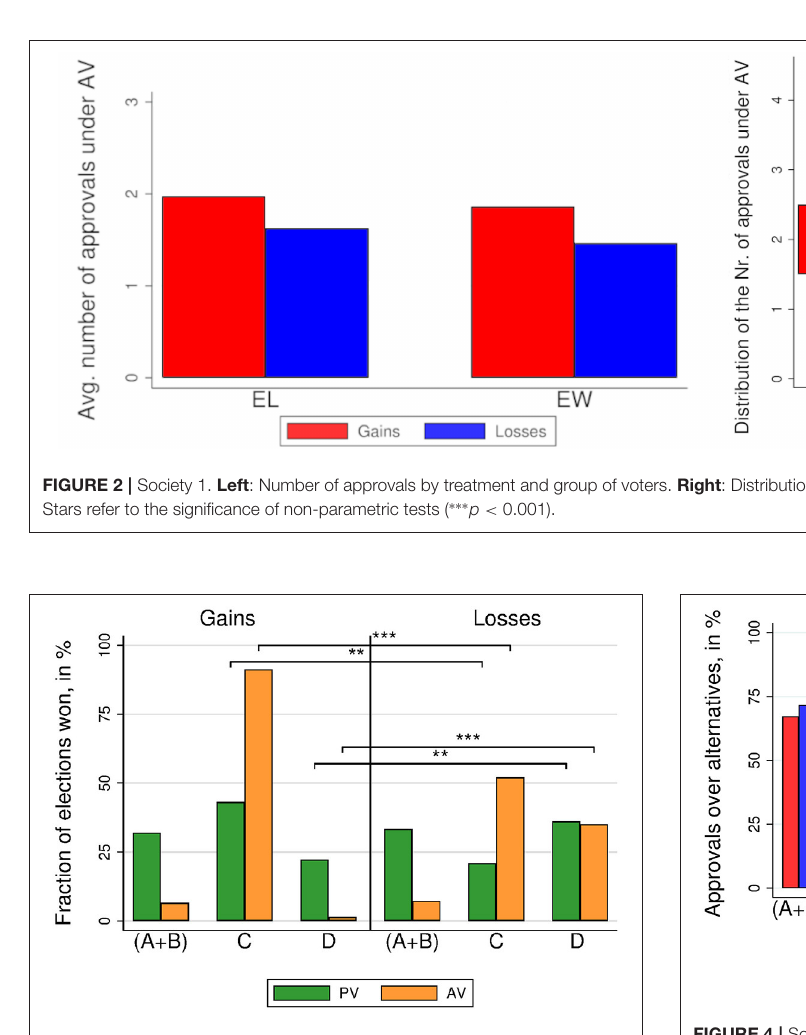
FIGURE 3 | Society 1. Election winners (including tied winners) by voting method and treatment. Stars refer to the significance of non-parametric tests ( ∗∗ p < 0.01 ∗∗∗ p < 0.001).